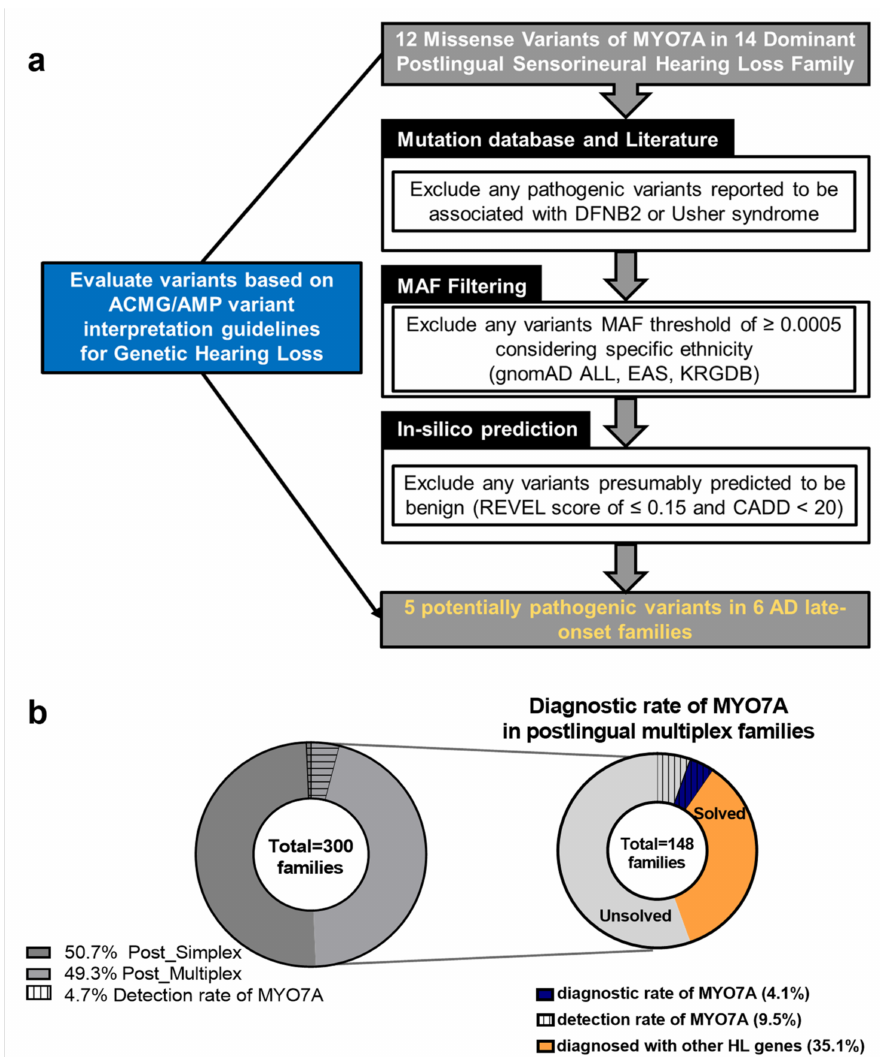
Figure 1. Diagnostic rate of MYO7A variants in families with multiplex post-lingual HL and filtering process based on ACMG guideline. ( a ) The pedigree configuration of 300 post-lingual HL families who underwent WES is on the right side. Detection rate of MYO7A variants marked with dashed line either in total post-lingual HL families (n = 300) or in post-lingual multiplex families (n = 148). All individuals genetically diagnosed with DFNA11 variants are members of unrelated post-lingual multiplex families, showing 4.1% of diagnostic rate (6/148 families) on the left colored in navy. ( b ) Filtering process utilized in evaluating all 12 detected MYO7A variants. After major three steps indicated above, 5 of 12 variants were identified as potential genetic cause of six probands with post-lingual hearing impairment suspected of dominant